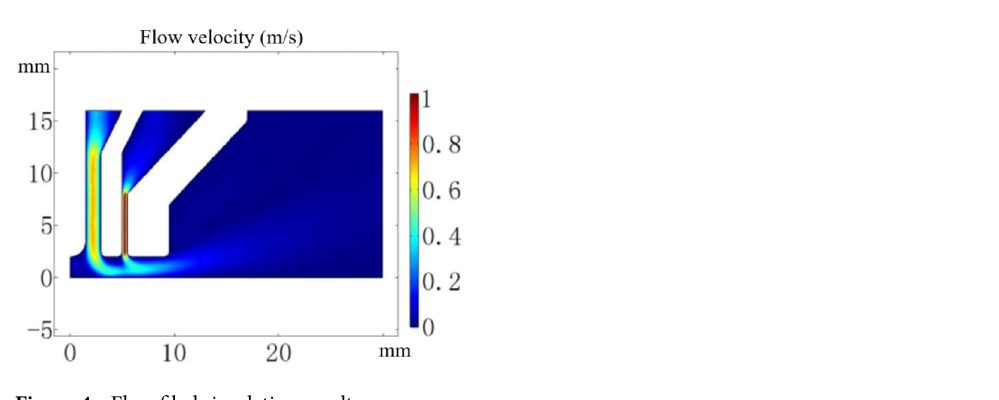
Figure 4. Flow filed simulation